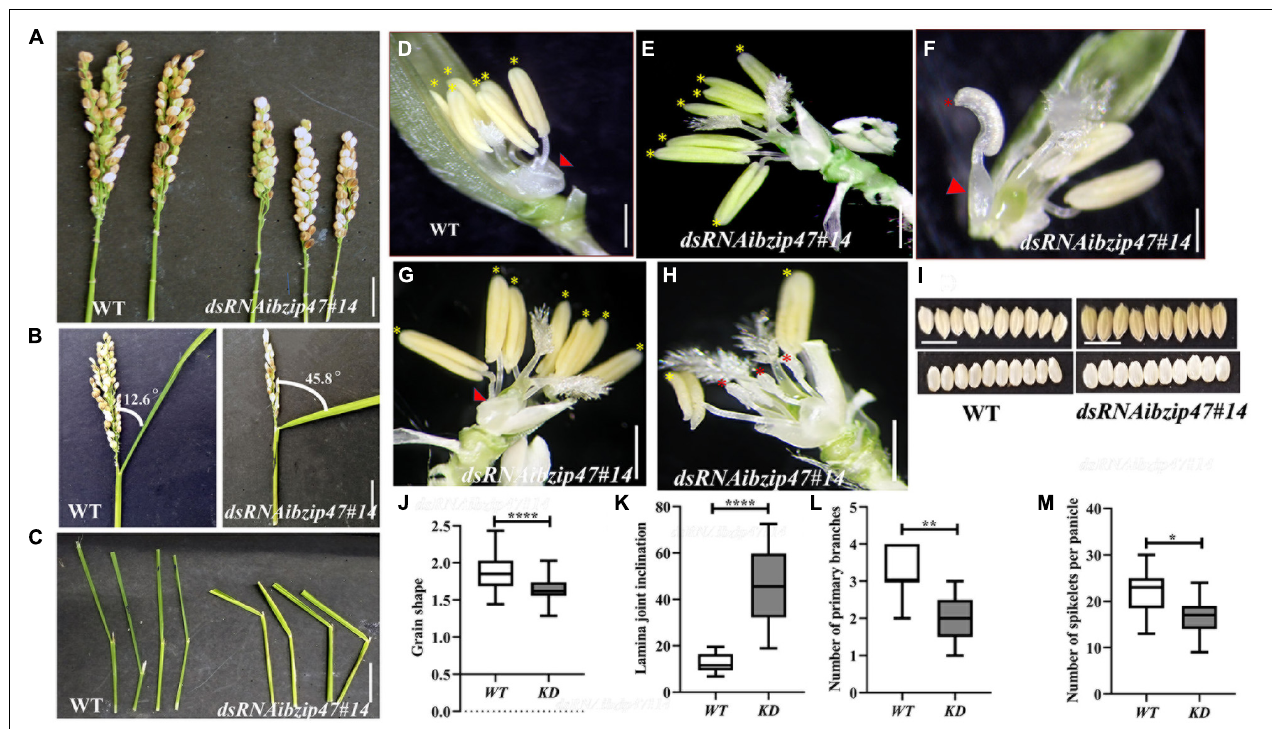
FIGURE 3 | Floret organ numbers and organ development in OsbZIP47KD plants. (A) Shorter panicle OsbZIP47KD with reduced number of primary branches and spikelet number per panicle as compared to the WT plant. (B,C) Flag leaf angle in fully headed panicles shows increased lamina joint angle in OsbZIP47KD plant as compared to the WT. (D) WT floret organs shown after removal of lemma and the spikelet sterile lemmas. Red arrow points to the pair of lodicules and yellow asterisks to the six normal stamens. (E–H) Organ phenotypes in OsbZIP4 7 KD florets. (E) Floret with seven stamens (yellow asterisks) with normal filaments and anthers. (F) Floret with mildly deformed lodicule (red arrowhead), two of its six normal stamens (others were removed) and a chimeric second whorl organ with lodicule and stamenoid features (red asterisk). (G) Floret with deformed lodicule and seven normal stamens (yellow asterisk). (H) Floret with slightly deformed lodicule, short stamens, and shrunken anthers (red asterisk), two near normal stamens (yellow asterisk). (I,J) Grain morphology in OsbZIP47KD and WT plants. The length/width (L/W) ratio of OsbZIP47KD seeds was lower than that of WT seeds, suggesting increased grain width. Scale bar = 1 cm in panels (A–I) . (J–M) Statistical analysis (mean ± s. d.) of grain shape, lamina joint angle, primary branch number, and number of spikelets per panicles. Data in panels (J) [ n = 40 in panel (J) ], (K) ( n = 10), (L) ( n = 11), (M) ( n = 9), Student’s t -tests, * P < 0.05, ** P < 0.01, *** P <